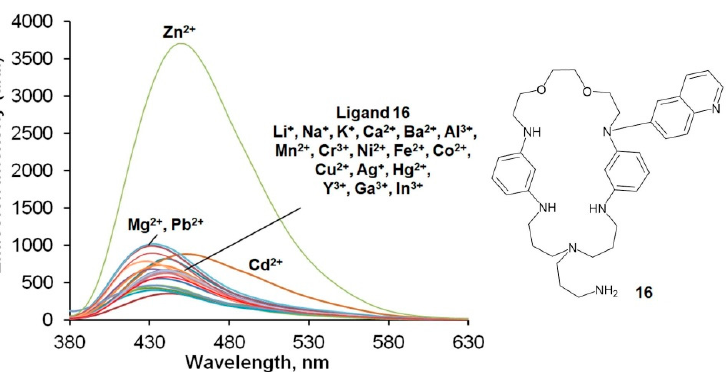
Figure 2. Spectra of the fluorescence of compound 16 in the presence of Li(I), Na(I), K(I), Mg(II), Ca(II), Ba(II), Al(III), Cr(III), Mn(II), Fe(II), Co(II), Ni(II), Cu(II), Zn(II), Cd(II), Hg(II), Pb(II), Ag(I), Ga(III), In(III) and Y(III) (five equiv.). C L 17.5 μ M, λ ex 370 nm.